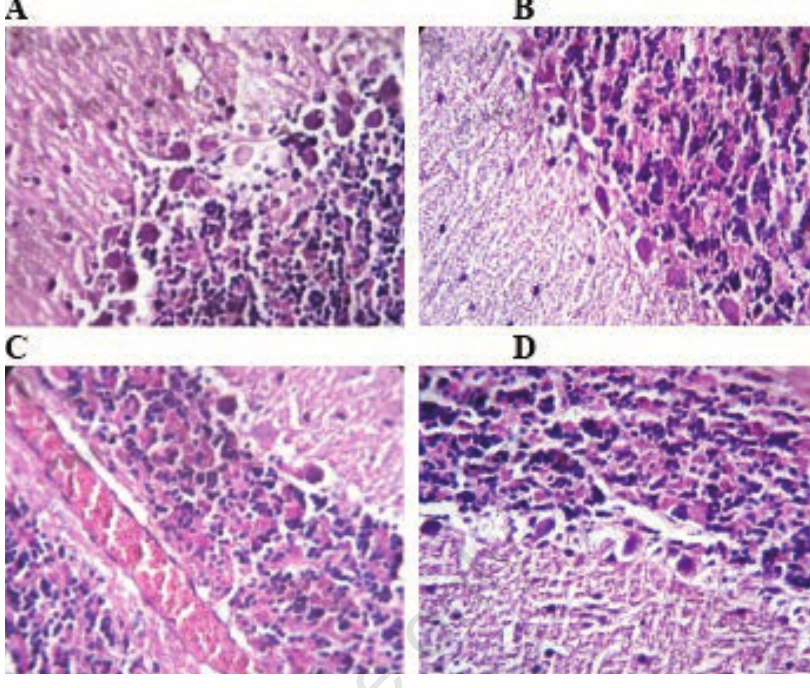
Figure 4. Histological architecture of the cerebellum in the control and TMX-treated groups. In control group (A) normal histological architecture of cerebellum shows intact Purkinje layer, molecular layer, granular layer and gray matter. Rats treated with TMX at 26 mg/Kg/b.w shows Purkinje layer with few necrotic Purkinje cells (B). Cerebellum of TMX-treated rats at 39 and 78 mg/Kg/b.w respectively (C and D) showing congestion severe vacuolation in the molecular layer with degeneration and detachment of pyramidal